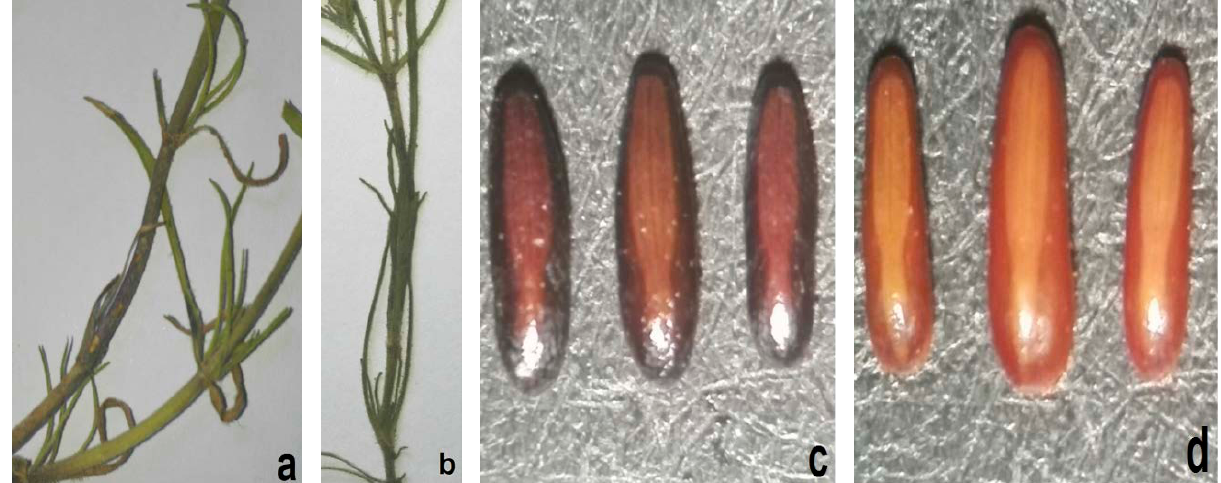
Figure 2. a: stem of population 1; b: stem of other populations; c: dark brown seed in population 1; d: light brown seed in other popula- tions.